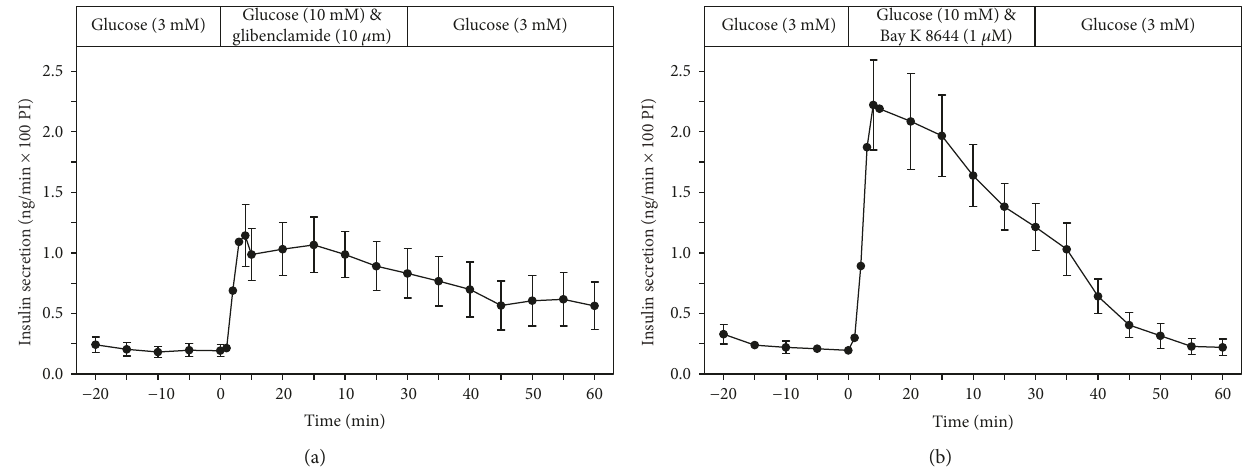
Figure 3: Kinetic pro fi les of insulin secretion from perifused EndoC- β H1 β -cell pseudoislets in response to a 30min stimulation with glibenclamide (10 μ M) (a) ( n = 5 ) as well as with Bay K 8644 (1 μ M) (b) ( n = 5 ) in the presence of glucose (10 mM) (a) ( n = 7 ). After a 20min preperifusion phase with basal glucose (3 mM), a 30min stimulation period and thereafter a return of the perifusion to basal glucose medium for another 30min are depicted. Shown are means ± SEM of insulin release rates expressed as ng/min and per 100 pseudoislets